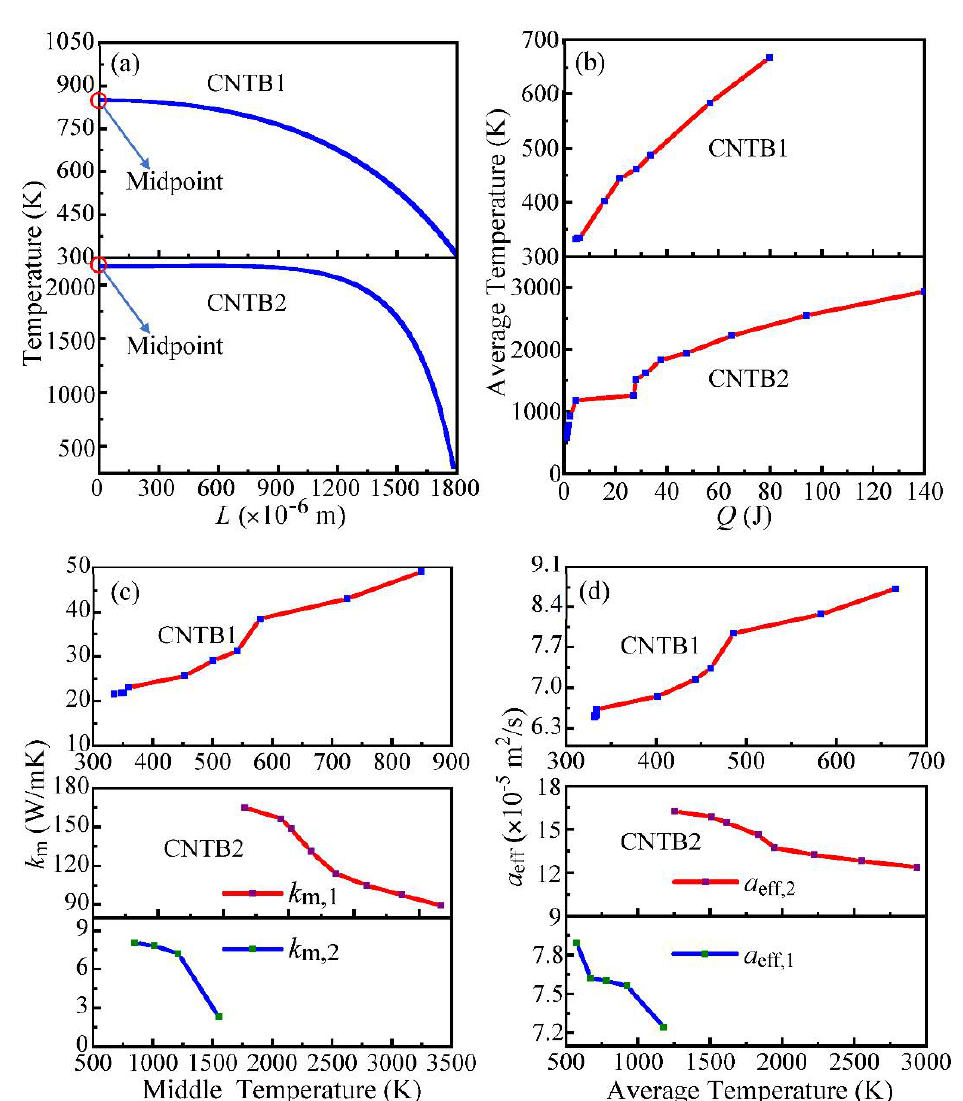
Figure 7. ( a ) Temperature distribution along the length of CNTB. The x-coordinate zero is the midpoint of the sample. ( b ) The average temperature of CNTB under different heating conditions. ( c ) Thermal conductivity of the midpoint varies with the annealing temperature of the midpoint. k m,1 and k m,2 correspond to the low thermal conductivity before switch-on and the high thermal conductivity after switch-on of CNTB2. ( d ) The thermal diffusivity varies with the average annealing temperature. α eff,1 and α eff,2 also correspond to the states before and after switch-on of CNTB2.